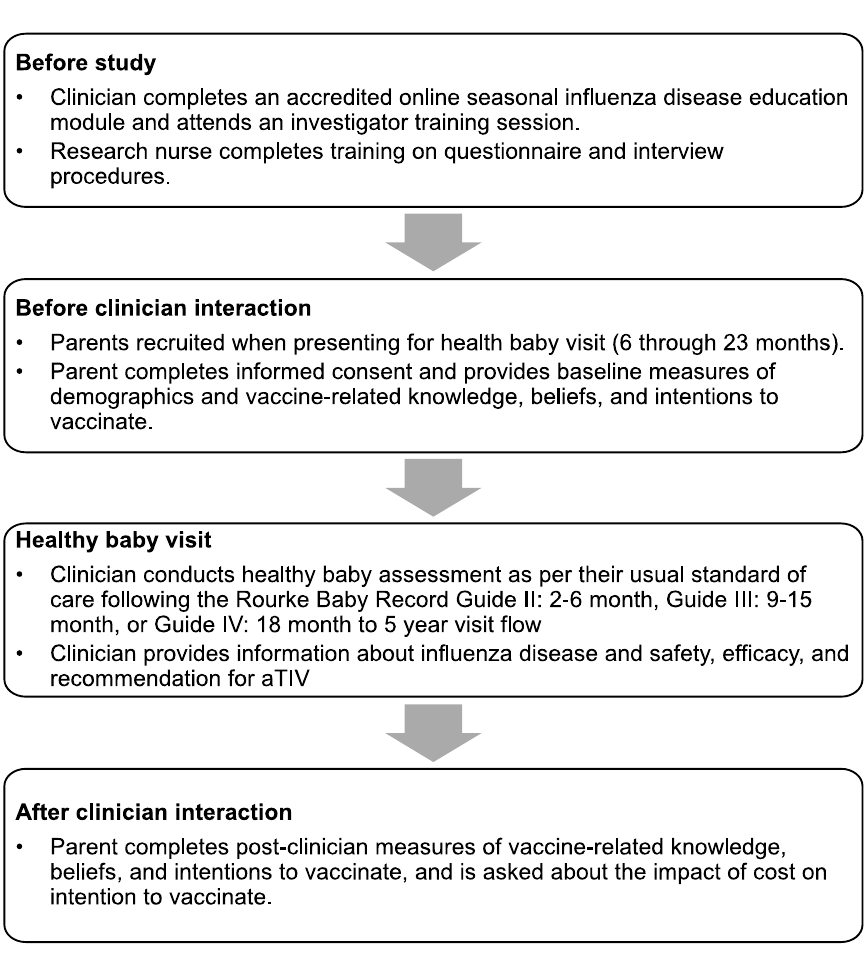
Figure 1. Study recruitment procedures and protocol flow.